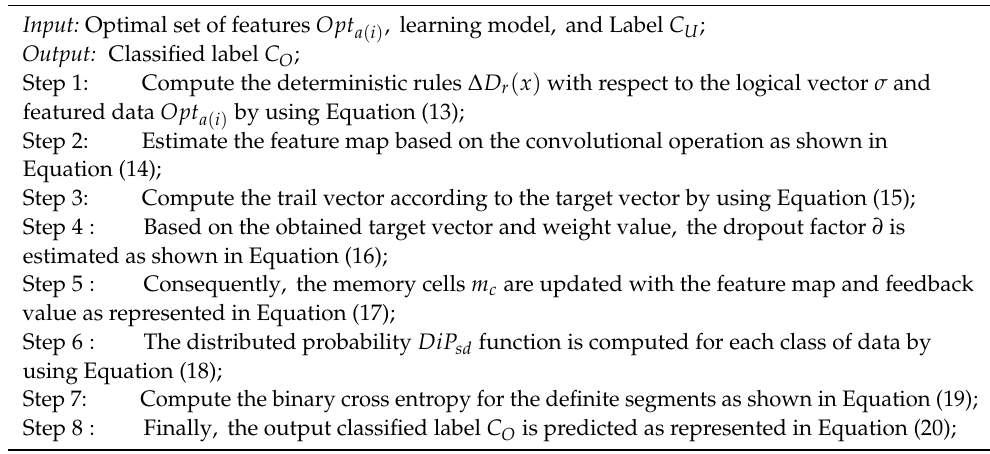
Algorithm 2 Deep Sequential Long Short Term Memory (DS-LSTM)